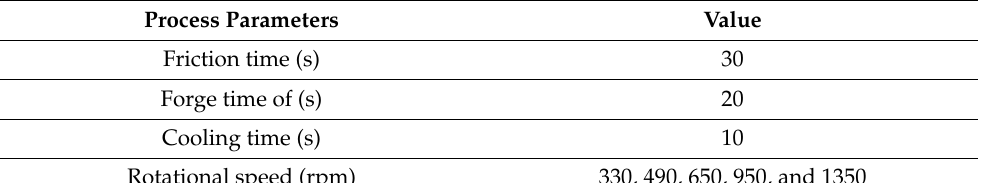
Table 1. Experimental conditions of FW.